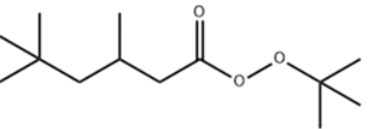
Figure 1. Chemical structural formula of TBPTMH.